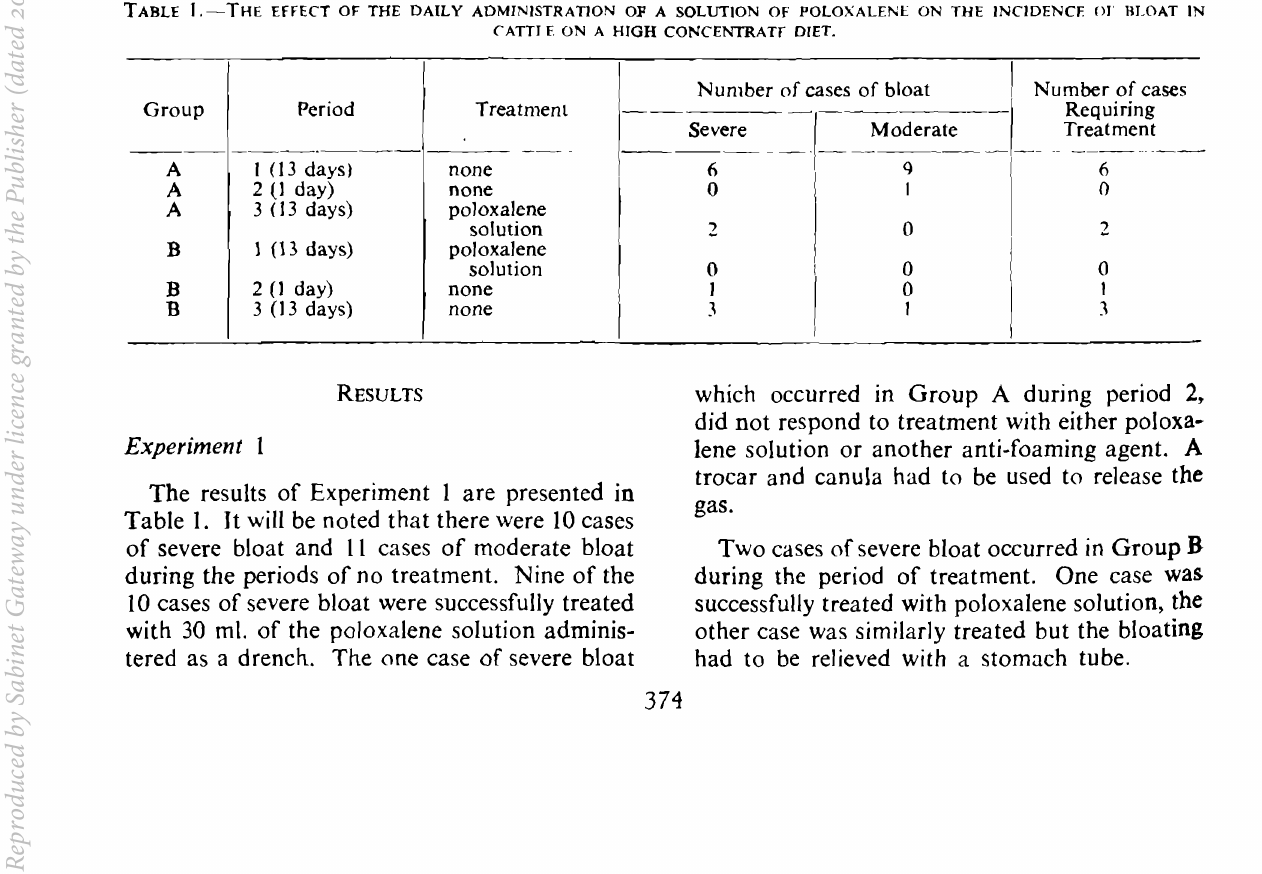
TABLE I.-THE EfFECT OF THE DAILY ADMINISTRATION OF A SOLUTION Of' POLOXALENE ON THE INClDENCf OJ BLOAT IN CATTI F ON A HIGH CONCENTRATf